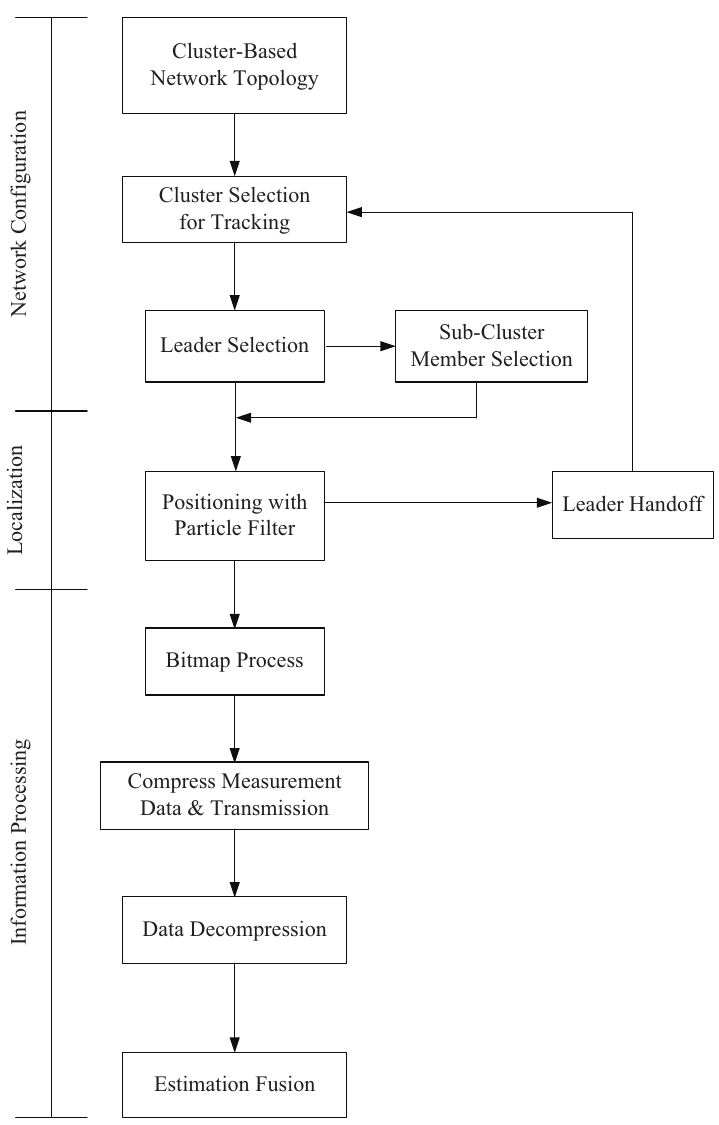
Figure 5. Illustration of the block diagram for the CTCI